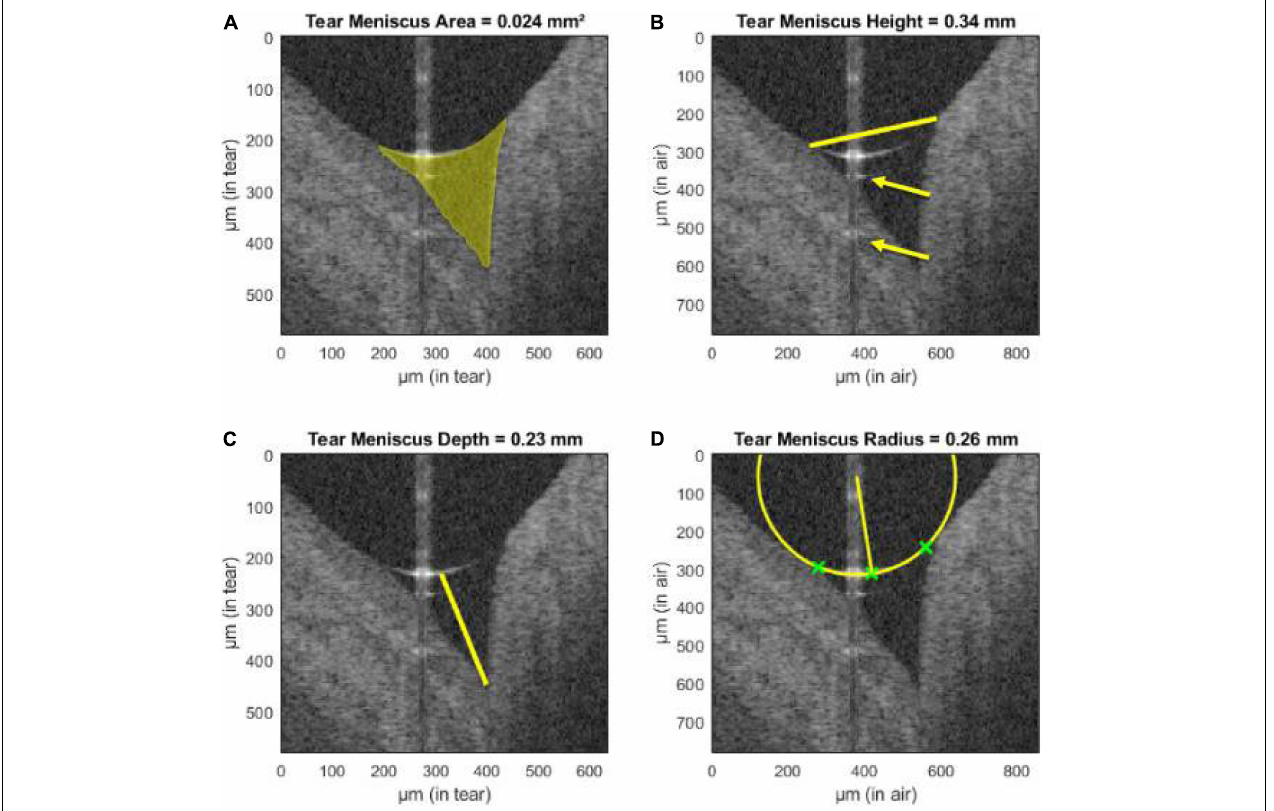
FIGURE 4 | Assessment of tear meniscus using UHR-OCT. Automatic segmentation of the lower tear meniscus in a healthy subject. Calculated parameters (represented in yellow) are (A) the tear meniscus area, (B) height, (C) depth, and (D) radius of curvature. Green crosses represent the points used for the estimation of the radius of curvature. The yellow arrows indicate mirror artifacts of the true upper meniscus boundary due to internal reflectors in the optical setup of the system. This figure was reprinted from Stegmann et al. (209) with